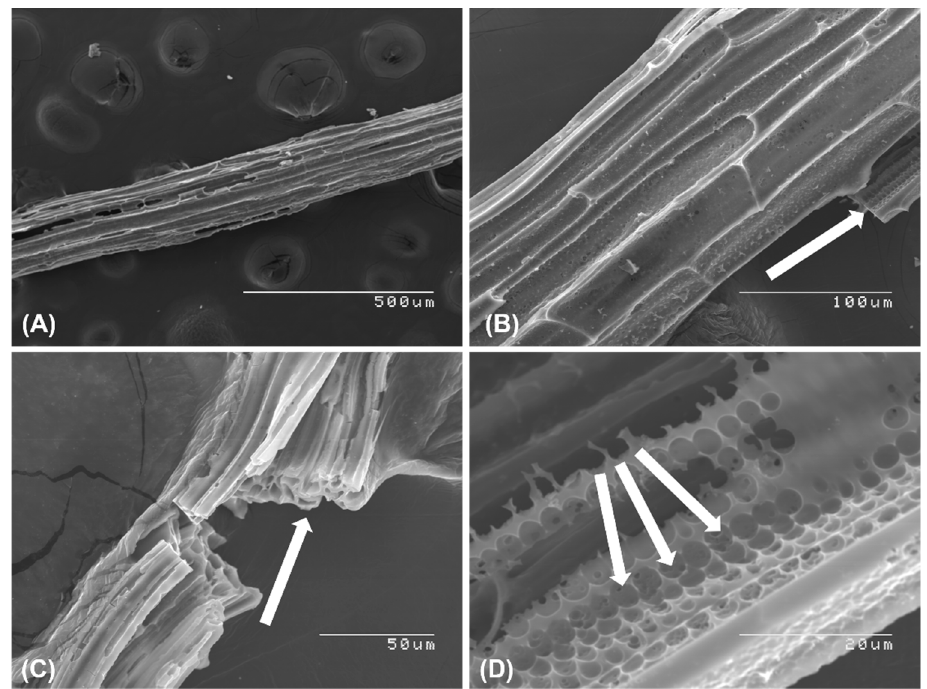
Figure 1. ( A – D ) SEM images of intact bagasse fibers treated with a saturated MB solution overnight which was used to develop the SC-MB hybrid nanocomposite. The scale bars in images ( A – D ) are 500 µm, 100 µm, 50 µm, and 20 µm, respectively. The arrows indicate the micropore structure within the SC.